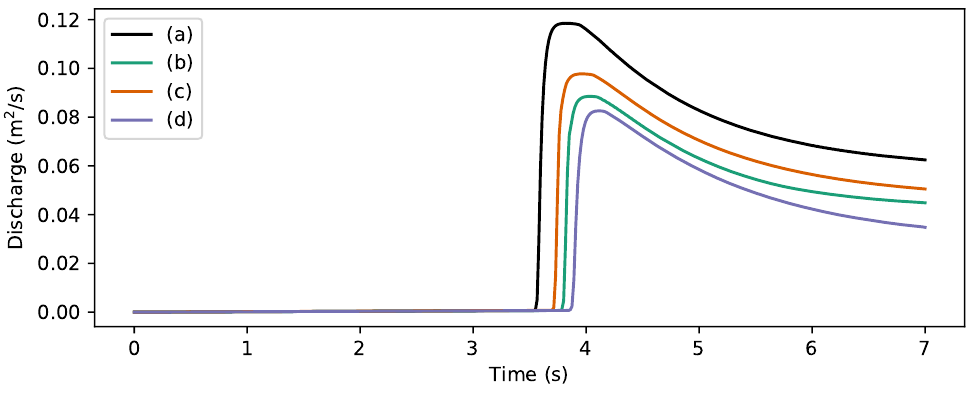
Figure 12. Flood hydrograph at x = 16 m for the dam break simulations for configurations